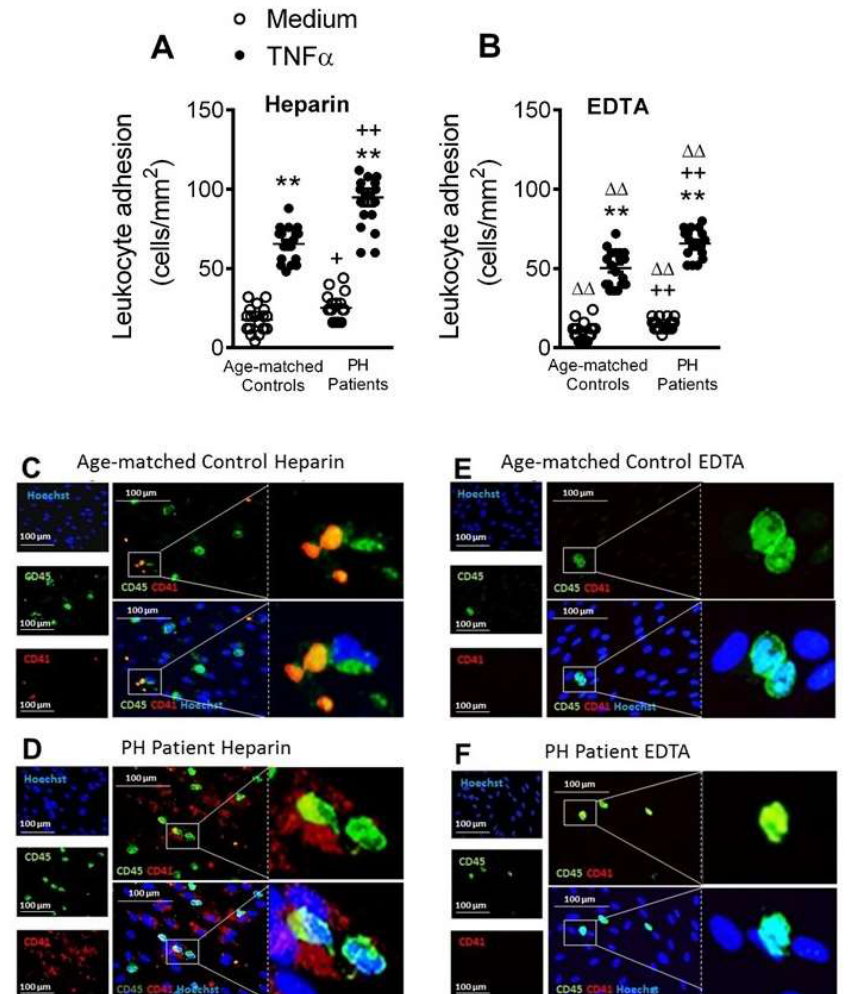
Figure 7. Circulating platelet-leukocyte aggregates and leukocytes from PH patients show increased adhesiveness to TNF α –stimulated HUAEC. HUAEC were stimulated or not with TNF α (20 ng/mL) for 24 h. Subsequently, whole blood from patients and controls, incubated without ( A ) or with EDTA ( B ), was perfused across endothelial monolayers for 7 min at 0.5 dyn/cm 2 and leukocyte adhesion quantified (cells/mm 2 ). Values are expressed as mean ± SEM ( n = 21 control subjects and n = 22 PH patients). ** p < 0.01 relative to values in the medium group; + p < 0.05 or ++ p < 0.01 relative to respective values in the control group; ∆∆ p < 0.01 relative to respective values in the heparin group. Immunofluorescence analysis showing adherent platelet–leukocyte cell complexes to TNF α -stimulated HUAEC ( C – F ). Heparinized blood from age-matched controls and patients with PH was incubated without or with EDTA. After the flow chamber assay, cells were fixed with 4% paraformaldehyde and blocked in phosphate-buffered saline (PBS) containing 1% bovine serum albumin (BSA). Then, cells were incubated for 2 h with an Alexa 488-conjugated antibody against human CD45 (1:50 dilution, green) and an allophycocyanin (APC)-conjugated antibody against human CD41 (1:50 dilution, red). Nuclei of endothelial cells and leukocytes were stained with Hoechst (blue). Images were captured with a Zeis Axio Observer A1 fluorescence microscope.